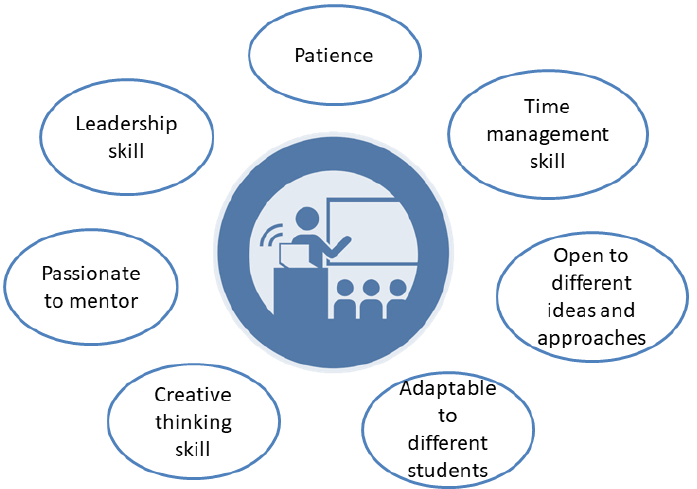
Figure 5. Teacher’s role in PBL (adapted from